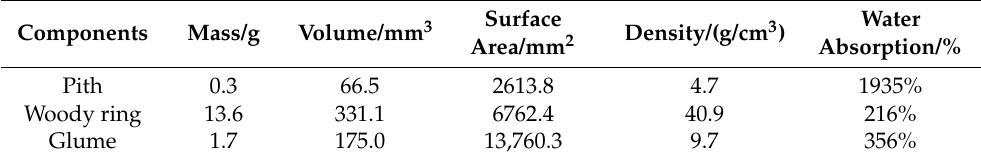
Table 1. Physical parameters of different components of corn cob (100 mm).